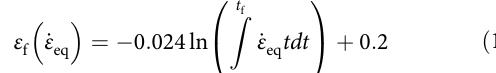
ð _ ε Þ data obtained from damage evolution component of the law is governed by the true f eq G c = 0.93 kJ m − 2 determined for this material in ref. 35 , for a t ð Þ ¼ _ ε t , over eq eq typical average crack speed of the order of 5 mms − 1 ; the latter is of the same order of magnitude with the average crack speed of 10 mm s − 1 (estimated via FE) occurring here during food